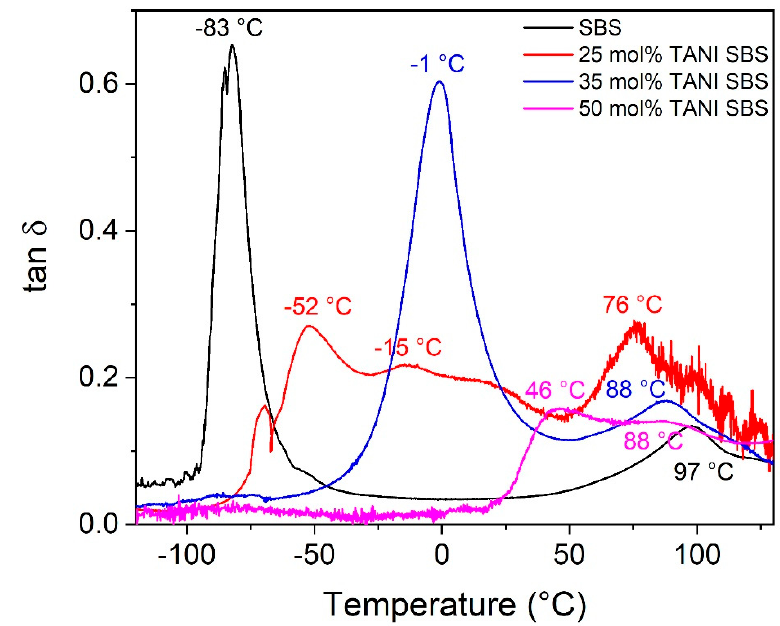
Figure 2. Dynamic mechanical thermal analysis (DMTA) tan δ for the T g of SBS, 25 mol% TANI-SBS, 35 mol% TANI-SBS and 50 mol% TANI-SBS.